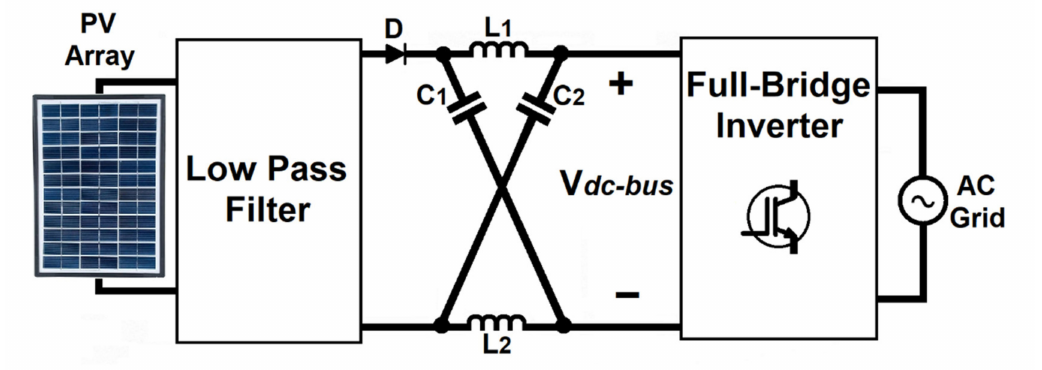
Figure 10. Schematic diagram of a Z-source inverter (ZSI) for a PV / grid-tied system